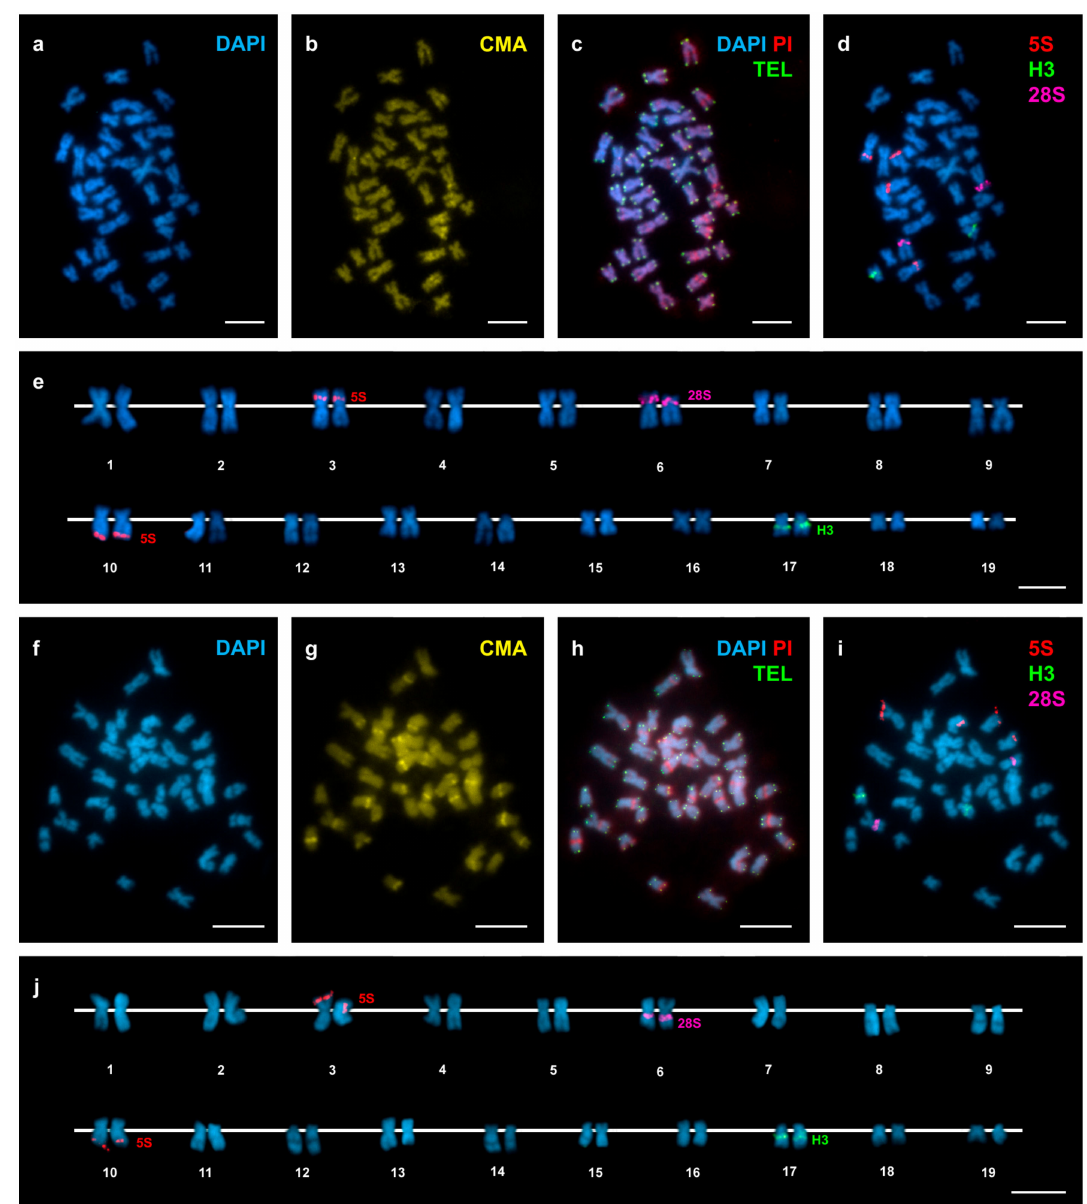
Figure 2. Mapping of telomeric sequence, 5S rDNA, 28S rDNA, and H3 histone gene clusters on Donax trunculus chromosomes. Sequential fluorochrome staining of mitotic metaphase plates shows 4 (cid:48) ,6-diamidino-2-phenylindole (DAPI)-negative regions ( a , f ) that fluoresce yellow after chromomycin A3 (CMA) ( b , g ) and bright red after DAPI/ propidium iodide (PI) ( c , h ) staining in both Atlantic ( a – c ) and Mediterranean ( f – h ) specimens of Donax trunculus . Hybridization of the same metaphase plates ( c , h ) with a telomeric peptide nucleic acid PNA probe discloses signals (TEL, green) at both ends of every chromosome. Sequential fluorescent in situ hybridization (FISH) experiments using major and minor rDNA and H3 histone gene probes on the same metaphase plates ( d , i ), and the corresponding karyotypes ( e , j ), show H3 histone gene signals (H3, green) intercalated in the long arms of chromosome pair 17. Minor rDNA probes (5S, red) map to two locations, intercalated in the short arms of chromosome pair 3 and subterminal to the long arms of chromosome pair 10. Major rDNA signals (28S, magenta) are intercalated in the short arms of subtelocentric chromosome pair 6 in Atlantic specimens ( d , e ) and subcentromeric to the long arms of metacentric pair 6 in Mediterranean specimens ( i , j ). Note that none of the chromosome pairs is telocentric. Scale bars, 5 µ